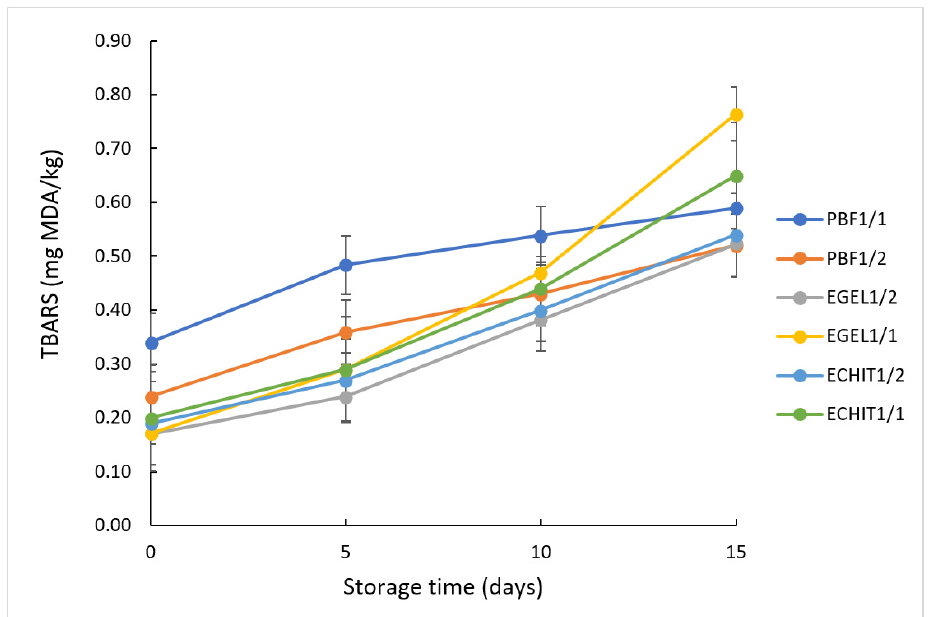
Figure 1. TBARS values (mg MDA/kg) of control and reformulated pork patties at 0, 5, 10 and 15 days of storage at 4 ° C; PBF1/1—normal fat patties; PBF1/2—patties made by half replacement of pork backfat with water; EGEL1/2—patties made by half replacement of pork backfat with EGEL; ECHIT1/2—patties made by half replacement of pork backfat with ECHIT; EGEL1/1—patties made by full replacement of pork backfat with EGEL; ECHIT1/1—patties made by full replacement of pork backfat with ECHIT.